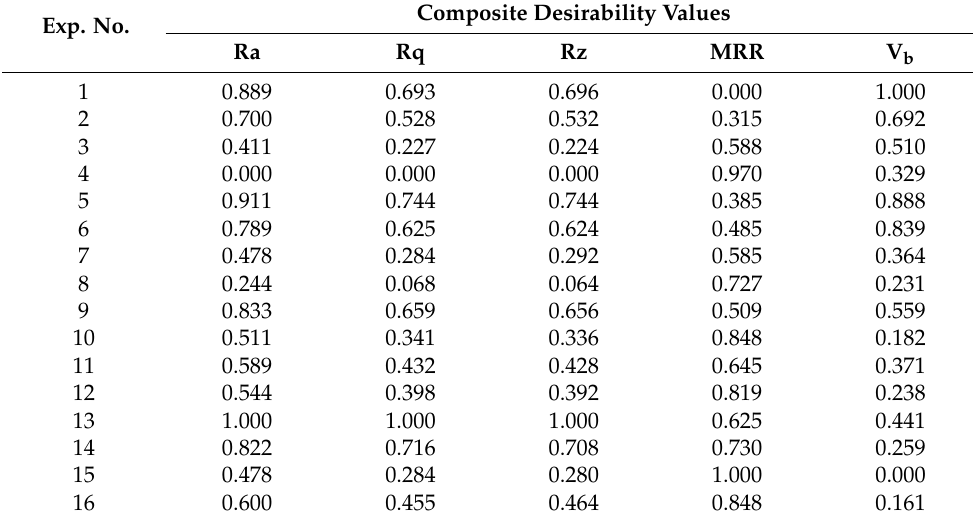
Table 7. Calculation of the composite desirability values.